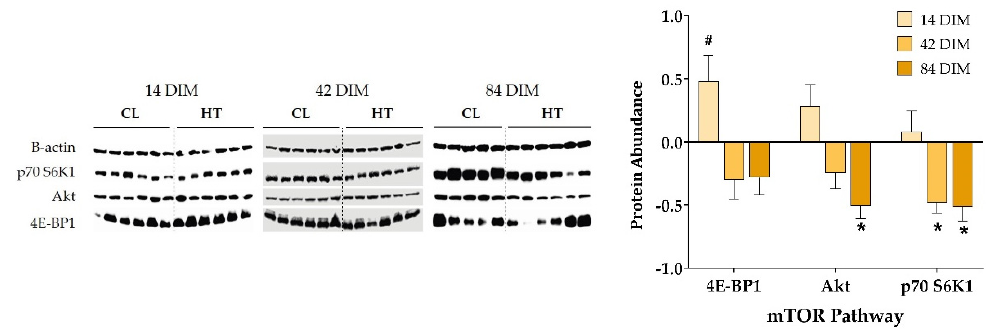
Figure 4. mTOR pathway protein abundance. Cows were exposed to dry period heat stress (dry-HT, n = 6) or cooling (dry-CL, n = 5) for 46 days pre-calving. Mammary biopsies collected at 14, 42, and 84 days in milk (DIM) were used for protein extraction to analyze mTOR pathway protein abundance by western blotting (Original picture, please see File S1). Protein expression is reported as abundance of dry-HT cows relative to dry-CL cows, normalized to β -actin. All data are presented as least square means ± standard error. * indicates p ≤ 0.05; # indicates 0.05 < p ≤ 0.10.